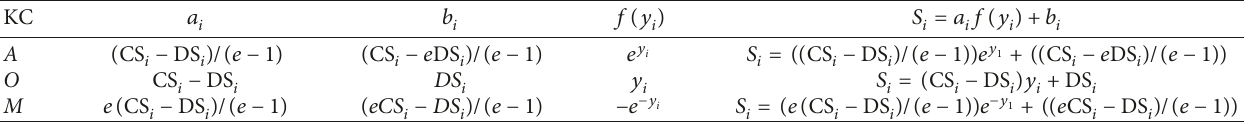
Table 1: CS-CR relational